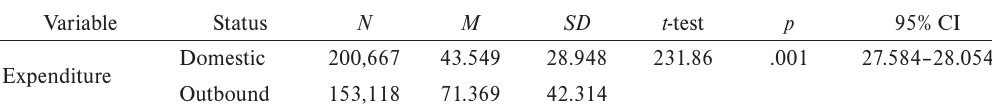
Differences in expenditure between domestic and outbound tourists